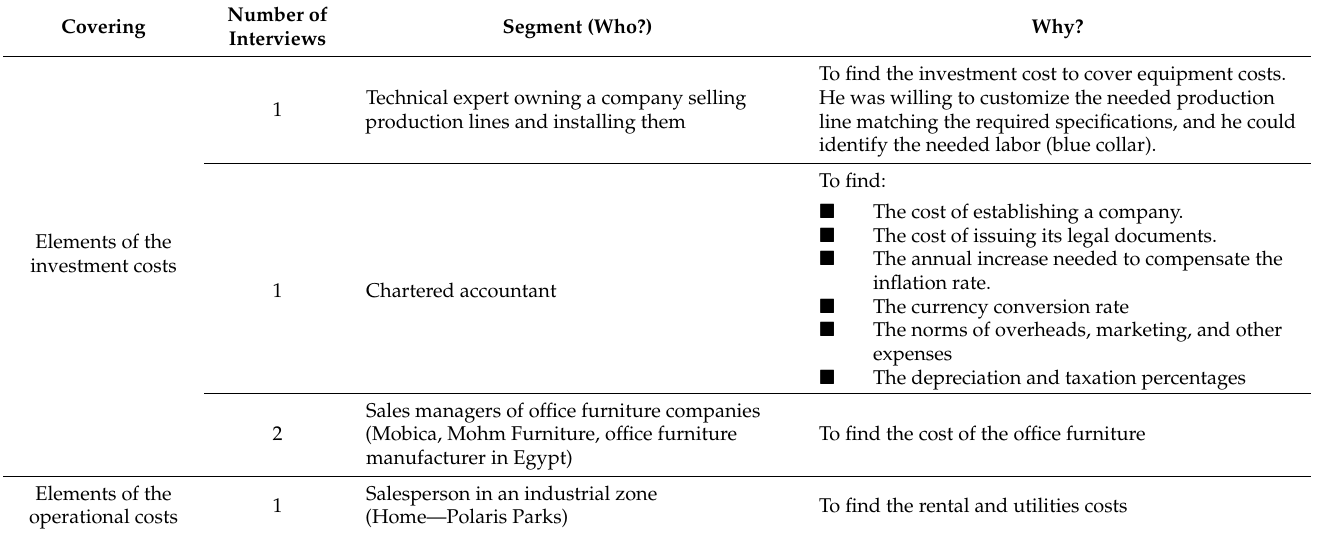
Table 3. Sample design of the experts’